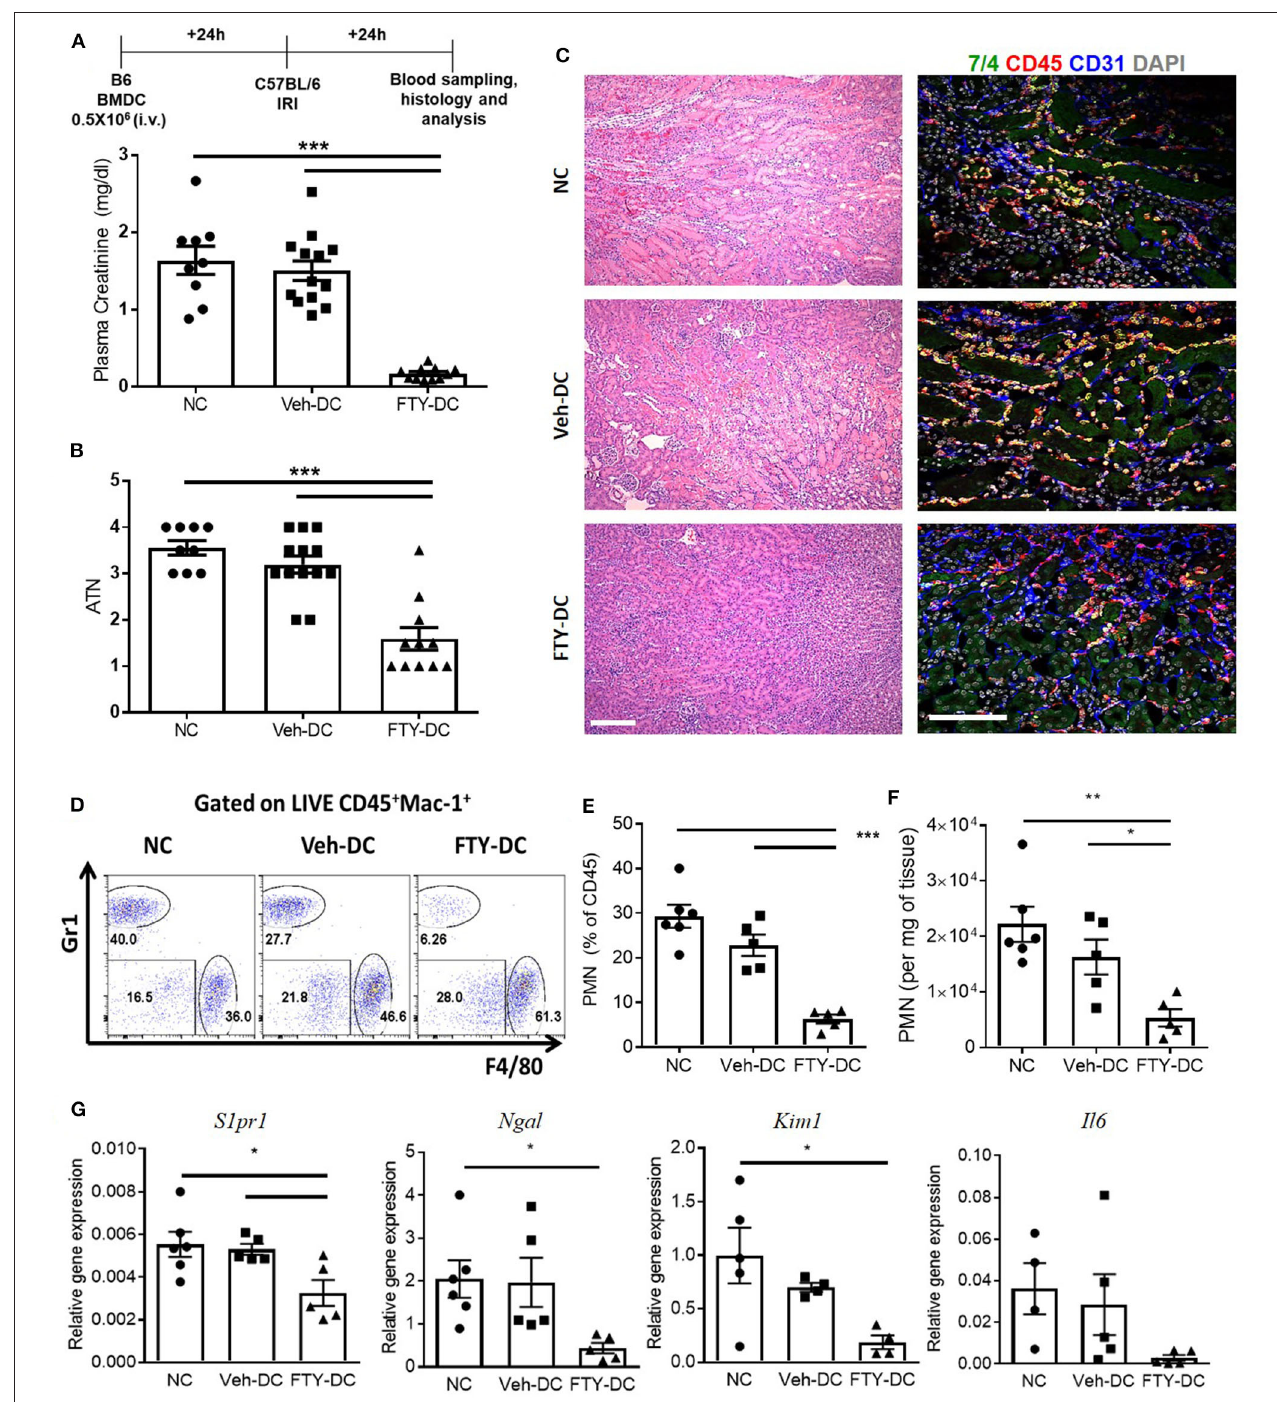
FIGURE 2 | Pretreatment with FTY-DCs protects kidneys from ischemia reperfusion injury. Mice were i.v. injected with 0.5 × 10 6 DCs (Veh-DC or FTY-DC) and as control no cells (NC) 1 day before bilateral kidney IRI. (A) Protocol for experimental setup and plasma creatinine. (B,C) Quantification of acute tubular injury (ATN). Renal histology (H&E). Scale bar, 100 µ m. (D–F) Flow cytometry of kidney tissue gated on neutrophils (CD45 + Mac-1 + Gr1 + ; PMNs) from mice either treated with NC, Veh-DC or FTY-DC. (G) Gene expression of kidney S1pr1, Ngal, Kim1, and Il6 . Data represent means ± SEM, * p ≤ 0.05, ** p ≤ 0.01, and *** p ≤ 0.001 one-way ANOVA followed by Tukey’s